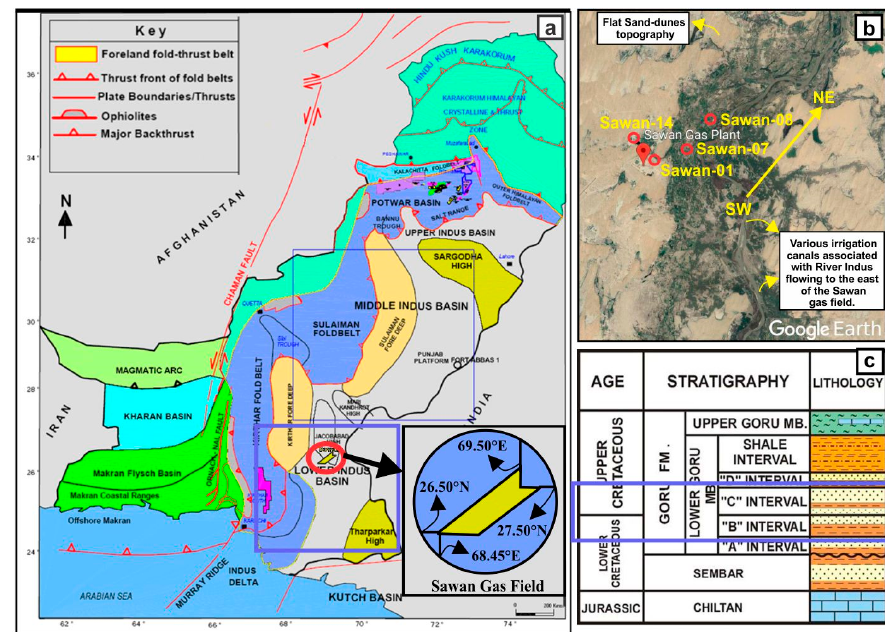
Figure 1. ( a ) Regional geological map of Pakistan. The Sawan gas field (SGF) is located close to the Jacobabad-Khairpur High (JKH) north of the Lower Indus Basin ( LIB) (highlighted by a blue square) [27]. ( b ) Location of the SGF showing the study wells on the imagery. ( c ) Stratigraphic chart of LIB. The blue rectangle highlights the zone of interest (ZOI) (modified from [35]).